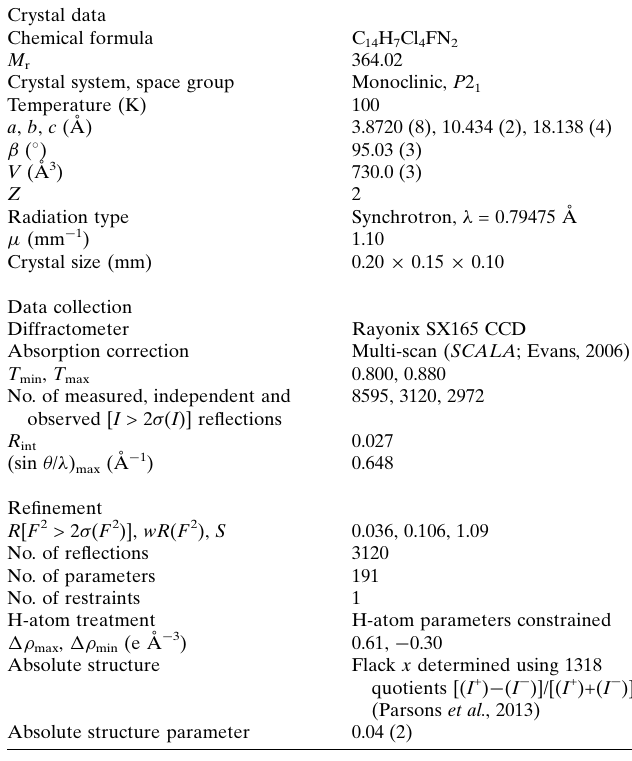
Crystal data Chemical